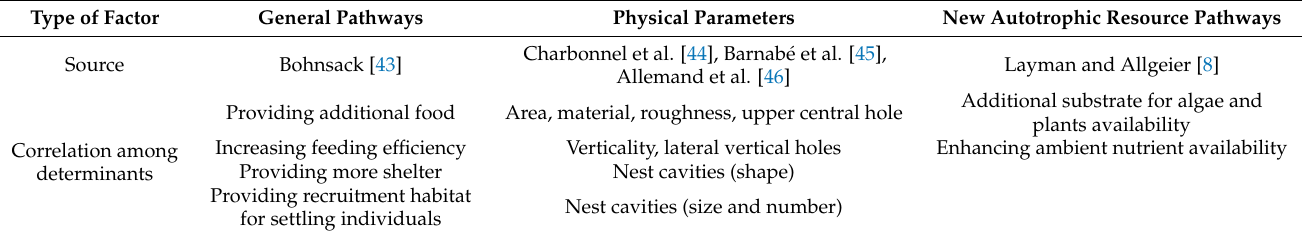
Table 1. Correlation among the determinant factors for increasing fish biomass, the environmental parameters of the ecosystem and the pathways for obtaining new autotrophic resources. Objective: identifying the correlation among determinants for the secondary productivity of the ecosystem.